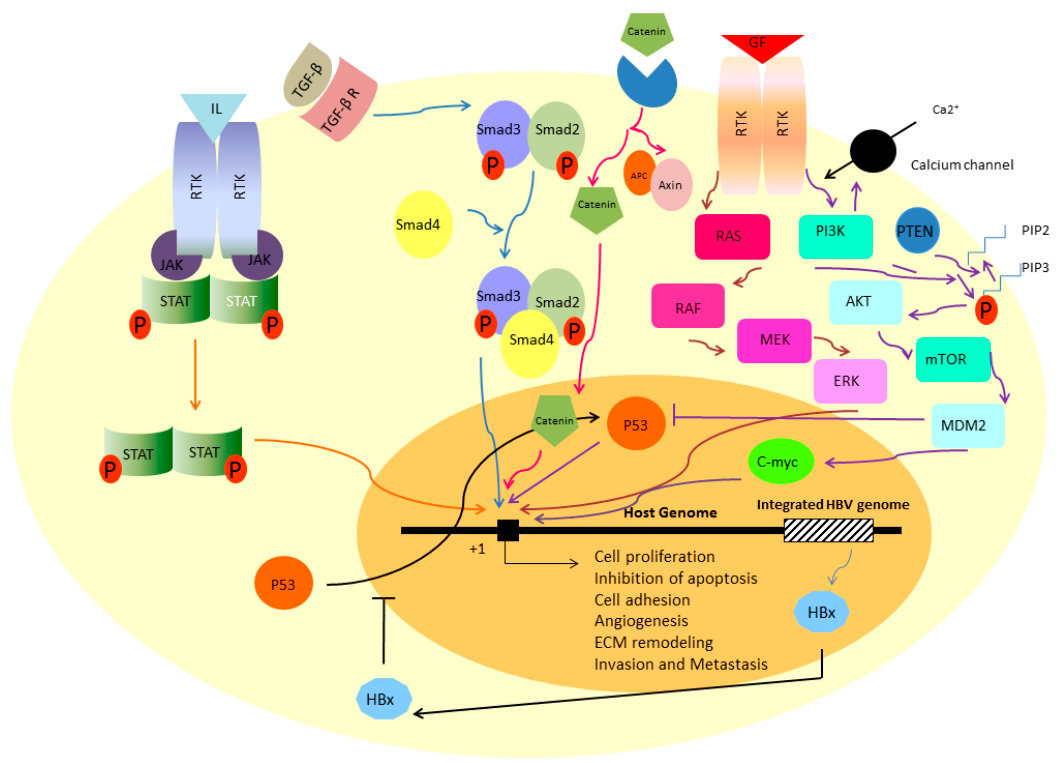
Figure 2. The most reported signaling pathways in HCC.